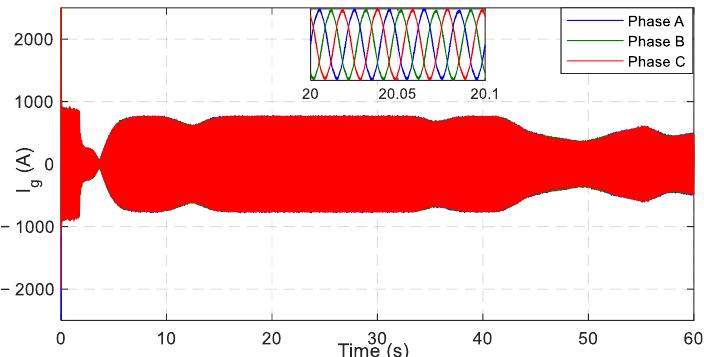
Figure 22. Grid currents of WECS with the proposed controller.